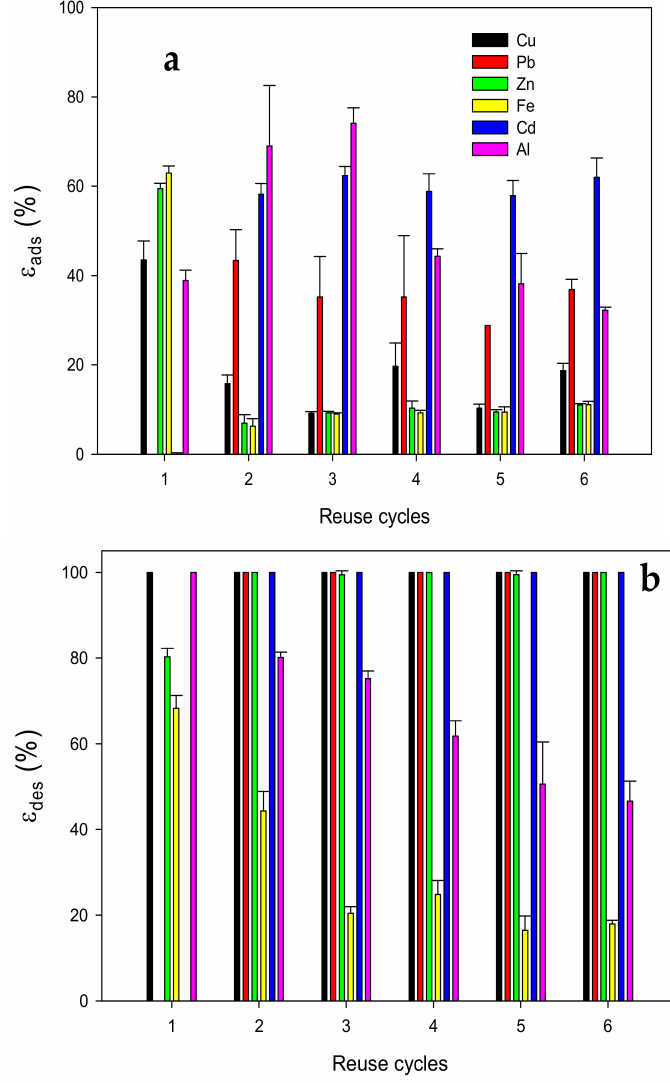
Figure 10. ( a ) Adsorption ( ε ads ) and ( b ) desorption ( ε des ) efficiencies of Cu ( black ); Pb ( red ); Zn ( green ); Fe ( yellow ); Cd ( blue ) and Al ( pink